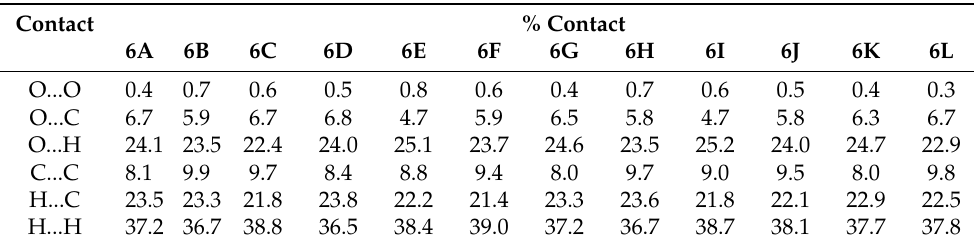
Figure 11. Hirshfeld d norm surfaces of the twelve molecular units per asymmetric unit of 6. Table 5. All contacts and their percentages for the twelve molecular units in the crystal structure of 6 a .